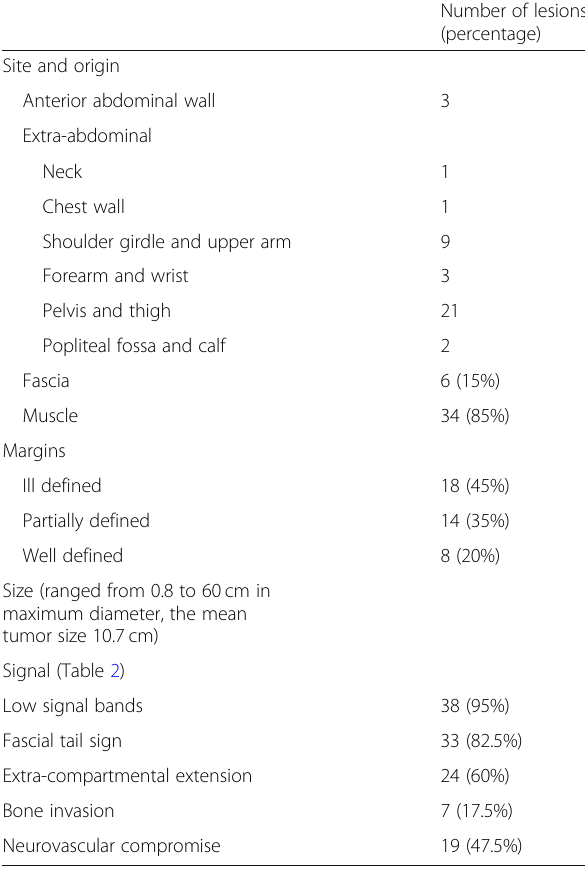
Table 1 The features of DF lesions on conventional MR images